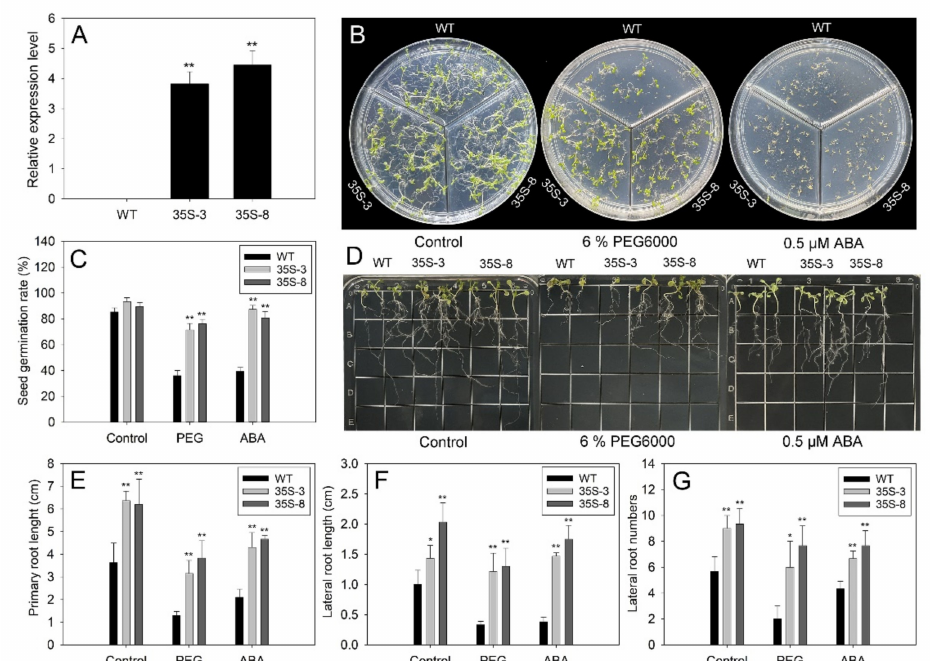
Figure 4. Drought and ABA responses of the transgenic Arabidopsis ectopic-expressing PtrbHLH66 during germination and post-germination growth. ( A ) Expression of PtrbHLH66 in the wild-type (WT) and two transgenic Arabidopsis lines (35S-3 and 35S-8). Analysis of ( B ) seed germination condition, ( C ) seed germination rates, ( D ) root growth condition, ( E ) primary root lengths, ( F ) lateral root lengths and ( G ) lateral root numbers of the two genotypes grown on MS medium containing 6% PEG6000 and 0.5 µ M ABA. All data are shown as the means ± SD calculated from three biological replicates. Asterisks indicate that the values in transgenic Arabidopsis are significantly different from that of the WT plants (** p < 0.01, * p <